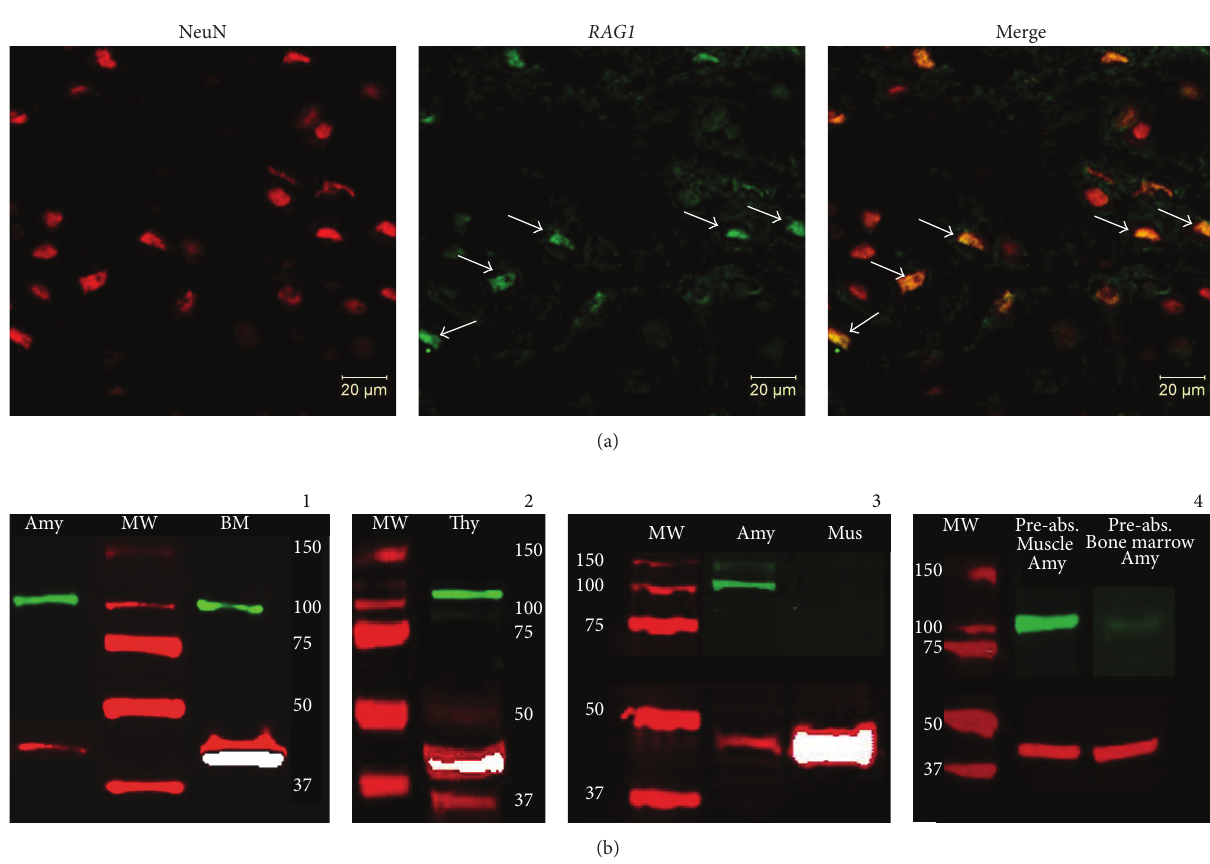
Figure 2: RAG1 protein expression in amygdalar neuronal cells. Amygdalar coronal sections of context fear conditioning-trained mice, perfused 1 h after conditioning, were used for immunofluorescence and analyzed by confocal microscopy. Antibodies from immunofluorescence were validated by Western blot analysis. (a) Amygdalar area representative images of a double immunostaining using RAG1 antibody labeled with Alexa Fluor 488, green channel signal, and NeuN antibody labeled with Alexa Fluor 568, red channel signal. The left panel shows the NeuN positive neuronal nuclei, while the middle panel depicts RAG1 immunopositive cells. The right panel is the merge image showing colocalization of the NeuN neuronal nuclei marker and RAG1. Arrows point to some of the RAG1 immunopositive neurons. These immunofluorescent images revealed colocalization of RAG1 protein expressing cells with those expressing NeuN, suggesting the presence of RAG1 in neurons, although not all neurons expressed RAG1. (b) Tissue punches from amygdala (Amy) were obtained 1h after context fear conditioning and analyzed in Western blot by comparative comigration with a standard molecular weight (MW) marker and proteinextractsfrombonemarrow(BM)((b)-1)andthymus(Thy)((b)-2).Bothsetsofexperimentsconsistentlyshowedcomigrationbetween the tissues with a band corresponding to ∼ 120KD of RAG1 protein (green channel corresponding to RAG1 and red channel corresponding to beta-actin, ∼ 42KD); prestained molecular weight (MW) marker (ladder) was included in all the Western blots. ((b)-3) Additionally, tissue protein extracts from leg muscle (Mus) (negative control) were analyzed compared to amygdalar extracts with respect to RAG1 expression. As expected, RAG1 was not expressed in muscle compared to amygdala ((b)-3), bone marrow ((b)-1), and thymus ((b)-2). ((b)-4) RAG1 antibody preabsorption assays, either with muscle or with bone marrow extracts, showed that only bone marrow extracts, which express RAG1 as opposed to muscle, were able to block the ∼ 120KD band from amygdalar protein extracts in the Western blots, indicating that RAG1 antibody was preabsorbed (blocked) only by RAG1 protein expressing tissue (bone